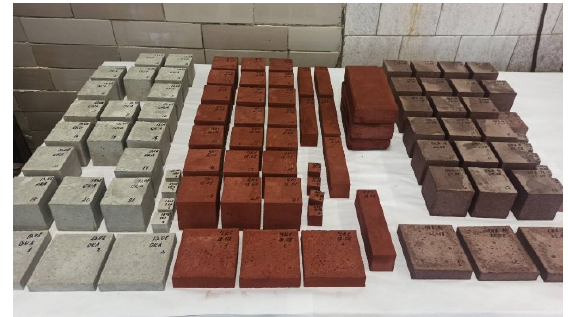
Figure 3. X-ray di ff raction pa tt ern of fi ne and coarse aggregates of concrete compositions: ( a ) = iron oxide powder; ( b ) = manganese oxide powder; ( c ) = iron ore pellets; ( d ) = alundum. Component composition of the concrete compositions is given in Table 1. Table 1. Composition of concrete.